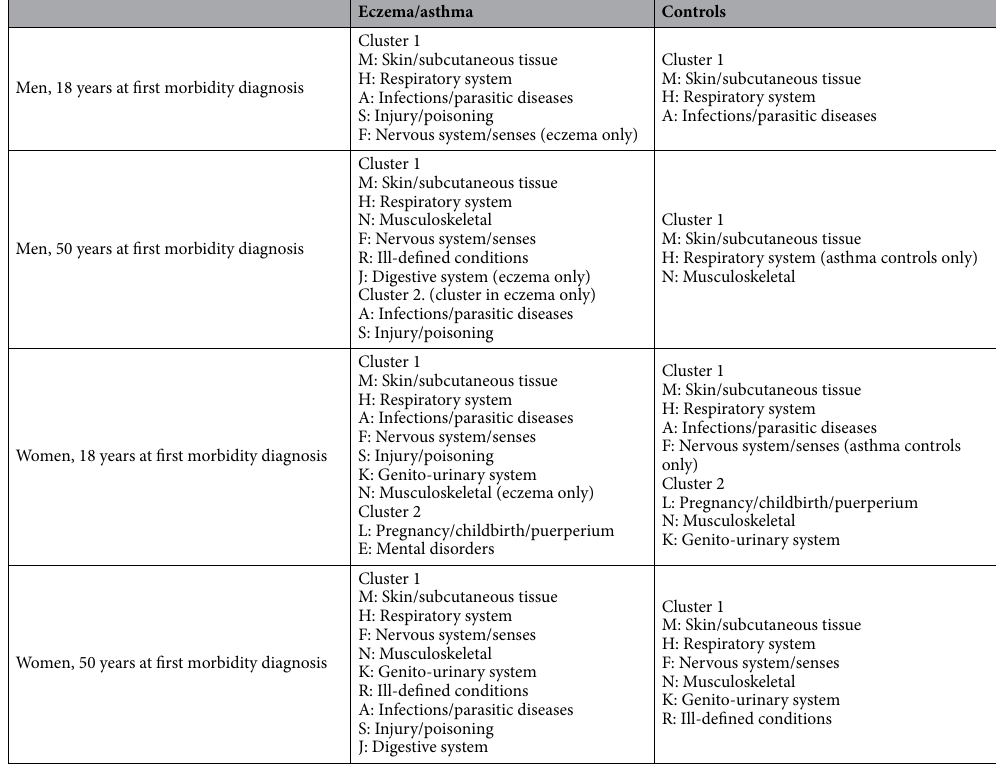
Table 2. Clusters of multimorbidity in people with eczema or people with asthma and controls without eczema or without